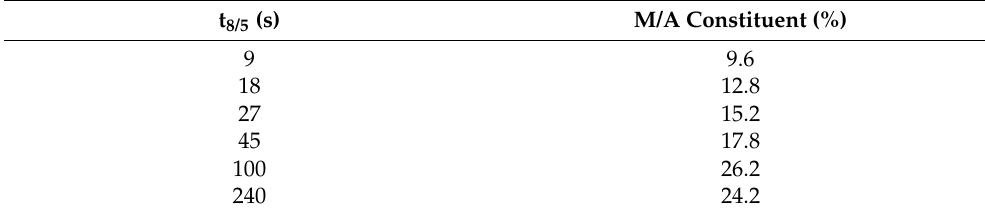
Table 2. The volume fraction of M/A constituent with cooling time t 8/5